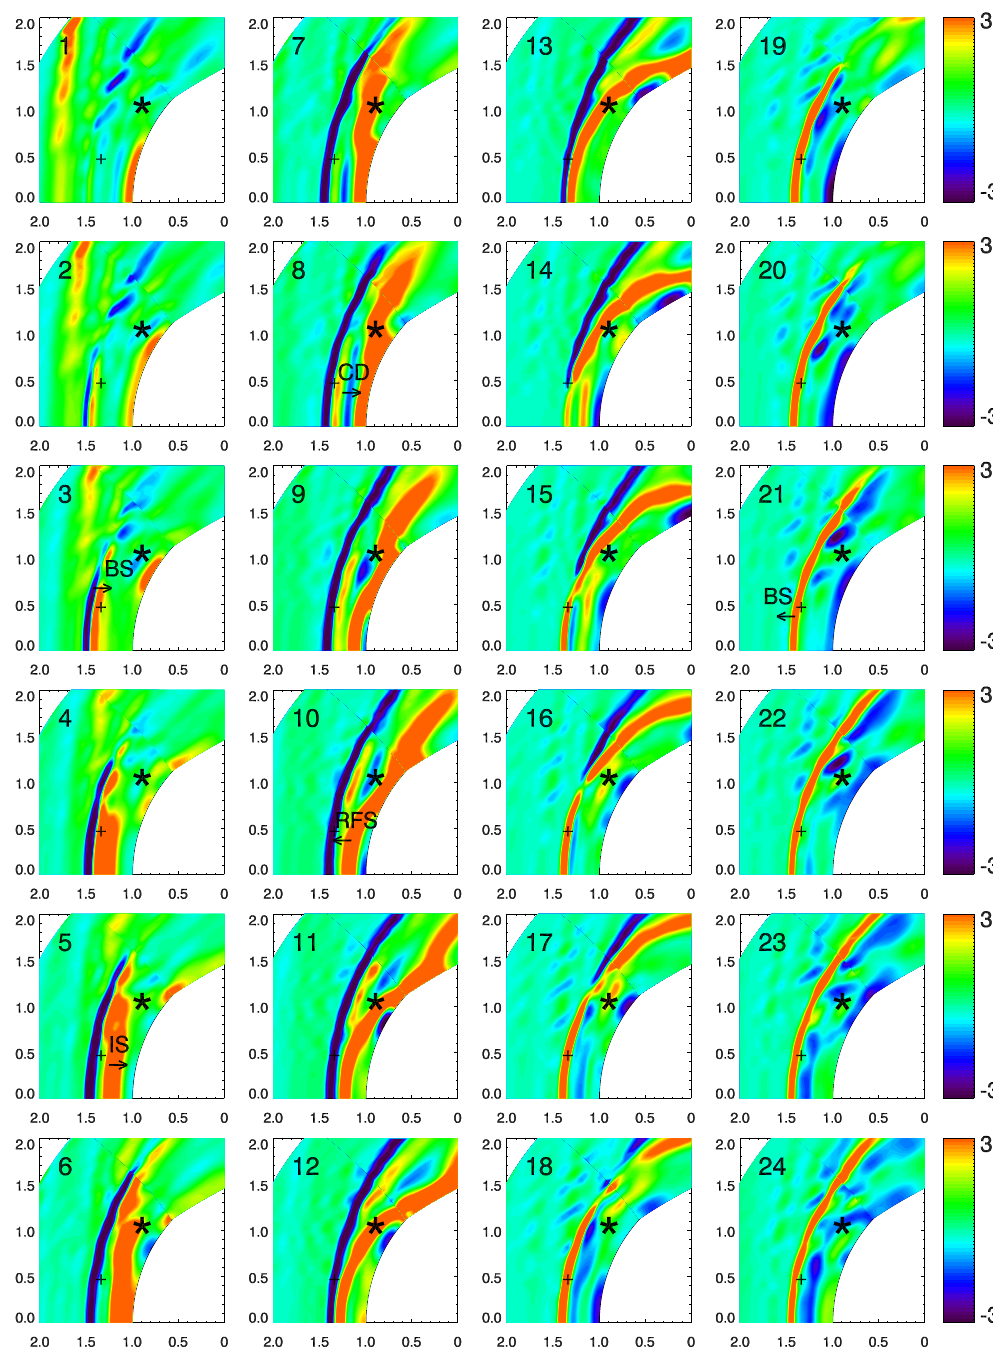
Fig. 10. Contours of 1B showing variations of field magnitude. The format is the same as that in Fig. 8. behind the transmitted IS and which is generated by the inter- action between the IS and the bow shock. This discontinuity is mainly charatherized by an increase of n , a decrease of T and a weak increase of B